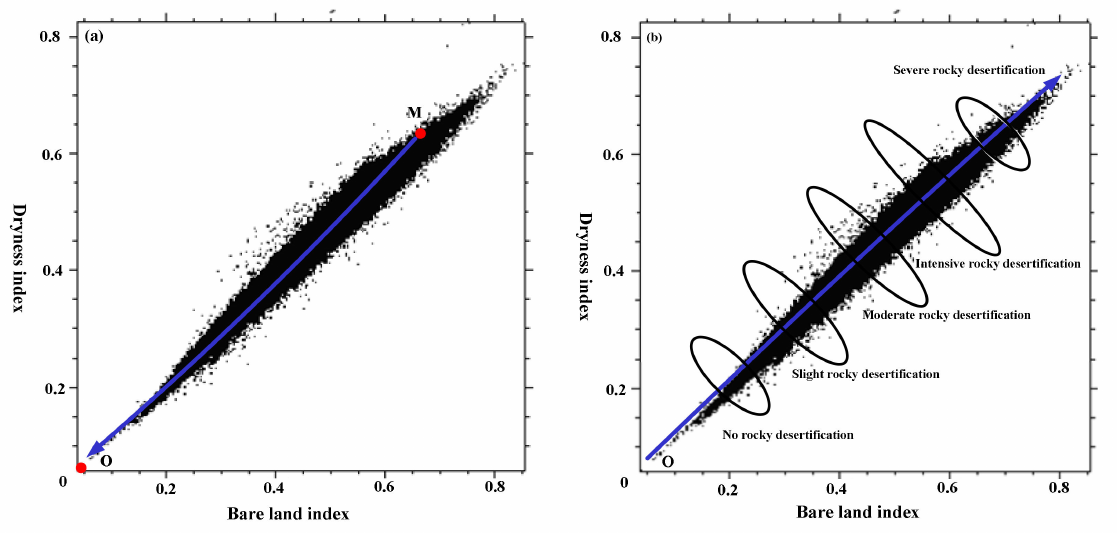
Figure 4. Construction of a point-to-point BLI-DI feature space rocky desertification monitoring model. ( a ) BLI-DI feature space; ( b ) Spatial distribution of levels of rocky